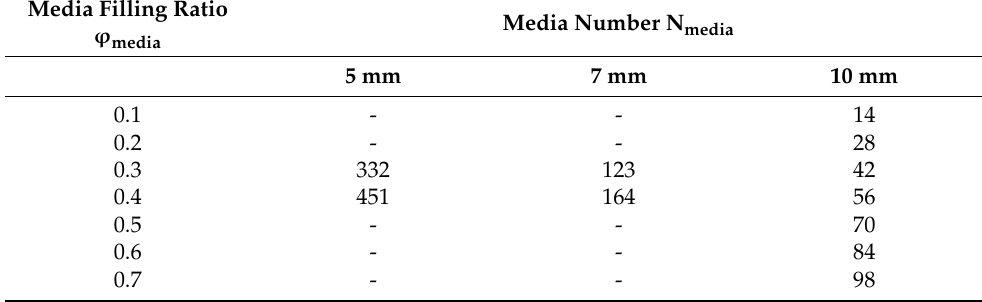
Table 3. Emax—media filling for V chamber = 125